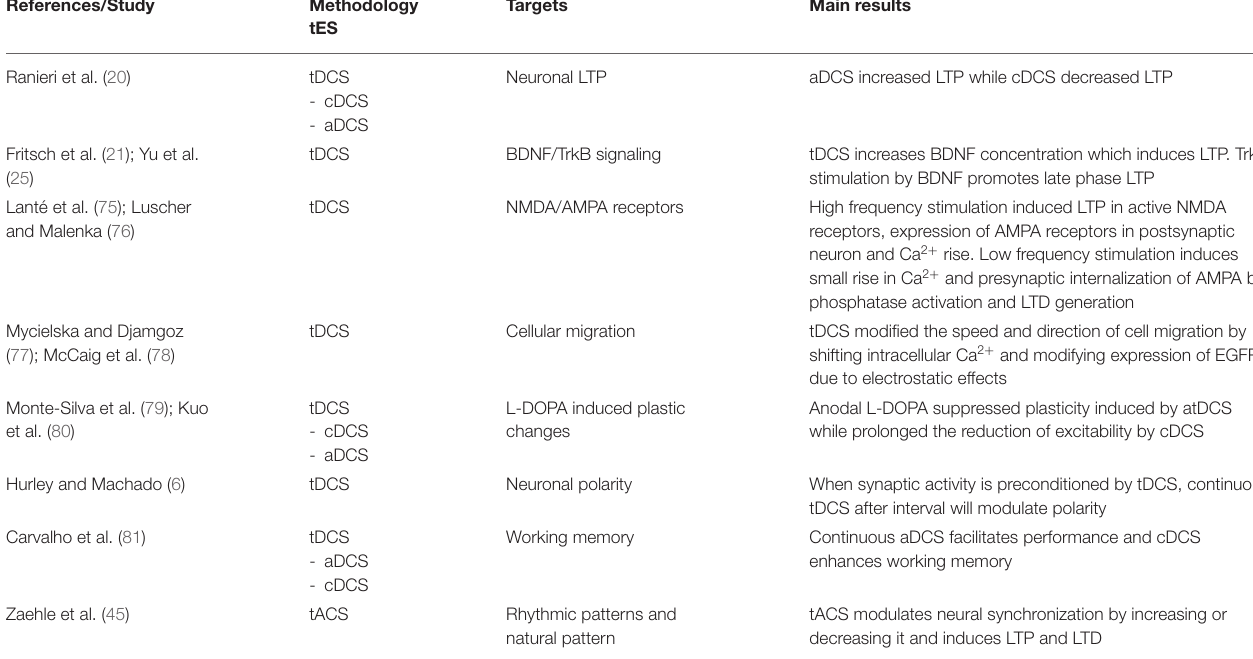
TABLE 3 | tES after-effects on synaptic